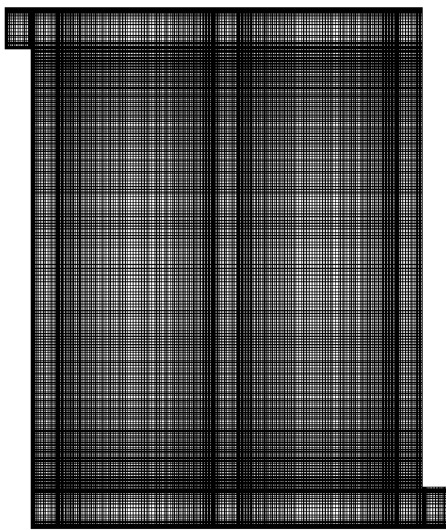
Figure 4. The mesh scheme of design D1 in front view.